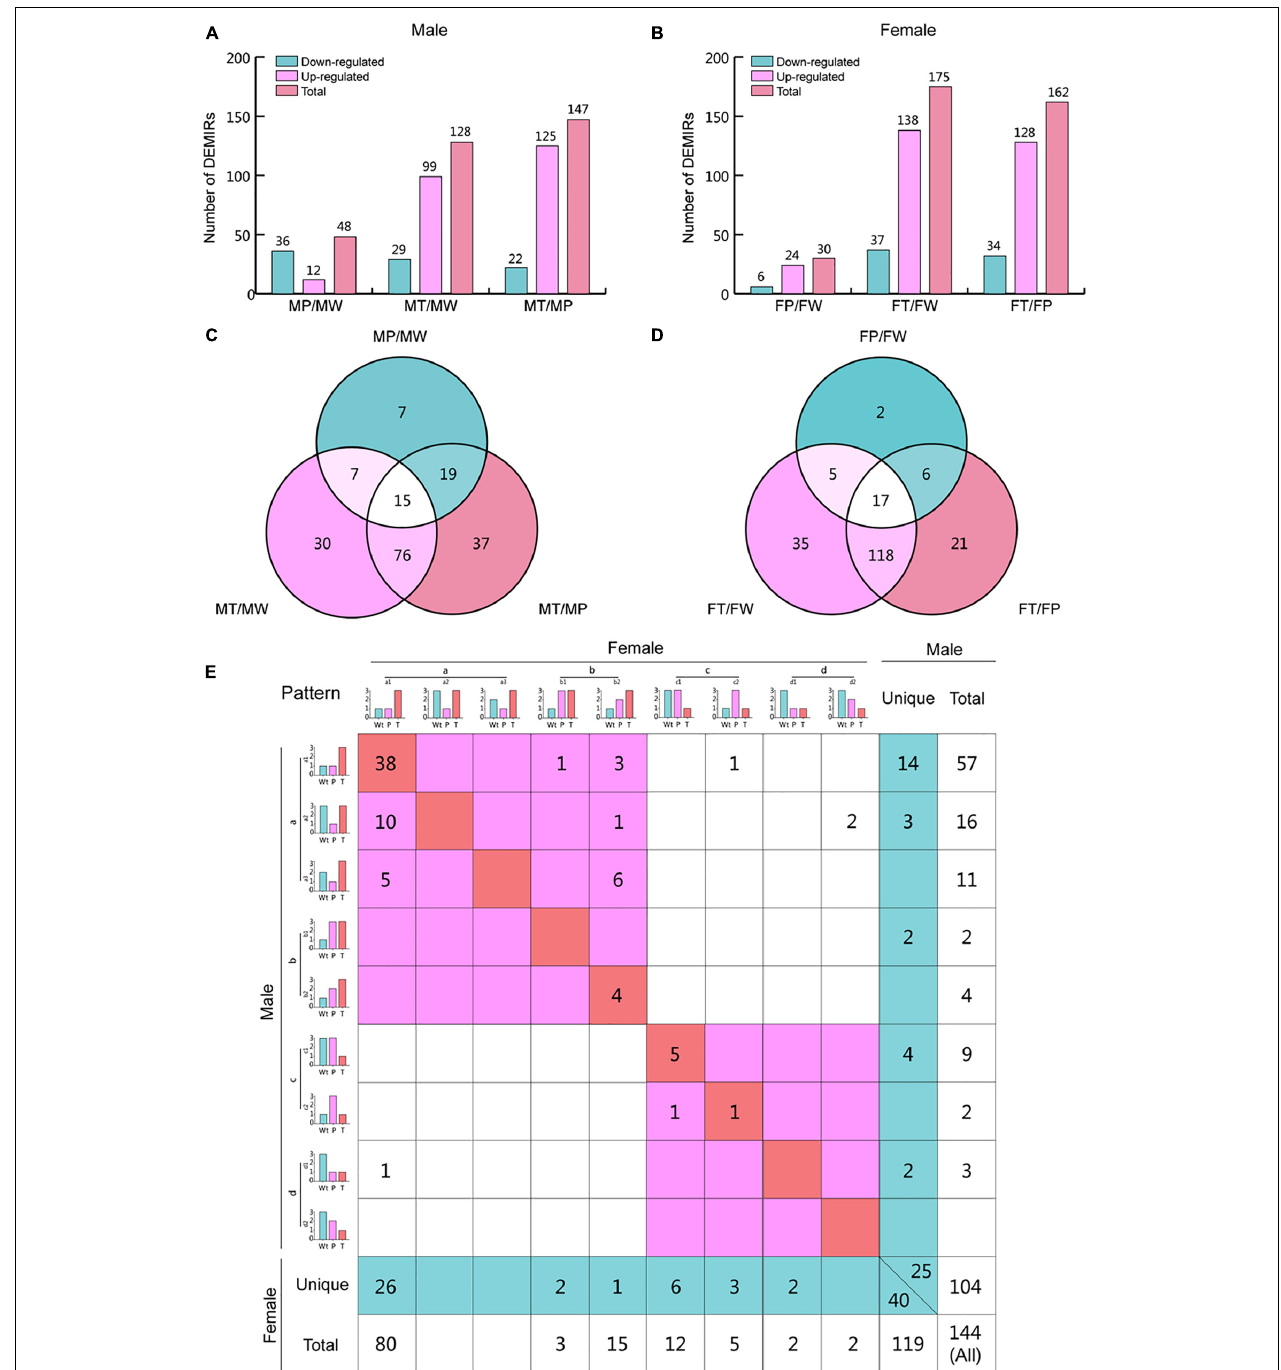
FIGURE 3 | Differentially expressed miRNAs (DEMIRs) obtained by vertical comparison and expression pattern analysis for hepatocarcinogenesis. (A) The number of miRNAs that are expressed at higher or lower levels when comparing MP/MW, MT/MW, and MT/MP in male mice. (B) The number of up- and down-regulated miRNAs when comparing FP/FW, FT/FW, and FT/FP in female mice. (C) Venn analysis of the DEMIRs shown in Supplementary Table 2.1 . (D) Venn analysis of the DEMIRs shown in Supplementary Table 2.2 . (E) Expression pattern analysis for hepatocarcinogenesis for both sexes. The diagonal line indicates that these miRNAs have the same expression patterns in both sexes. The miRNAs shown in the red area in the upper left are up-regulated in T as compared to P and/or W in both sexes. The miRNAs shown in the red area in the bottom right are down-regulated in T as compared to P and/or W in both sexes. The miRNAs shown in the blue area have a unique expression pattern in males and females. The relative expression levels of miRNAs are represented using a 1, 2, and 3 grading system, indicating significant differences in the miRNA levels. The DEMIRs that appeared at least two times in pairwise comparison among W, P, and T between sexes are shown here, and the expression pattern analysis for total DEMIRs is shown in Supplementary Figure 3